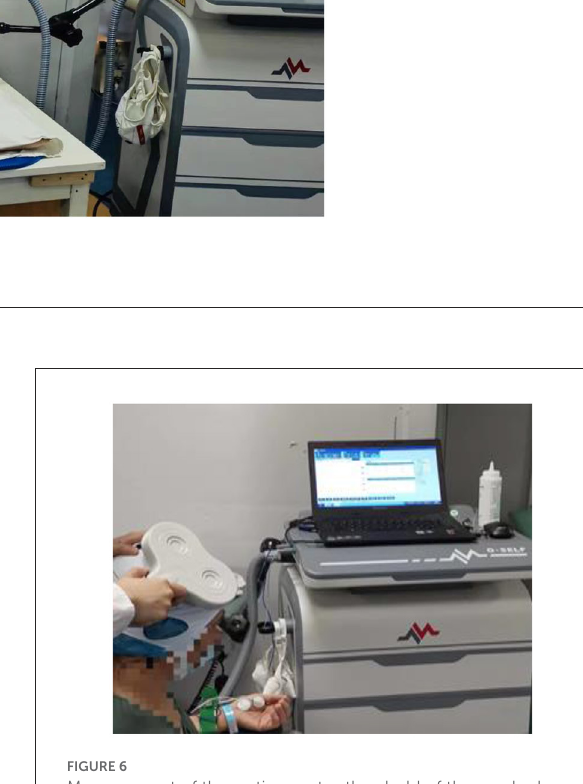
significant ( P < 0.05). When comparing between groups, there was no significant difference in FMA-UE scores between the three groups before or after treatment ( P > 0.05). The difference in the FMA-UE scores (improvement: change from baseline to post-intervention score) was significantly different among the three groups before and after treatment ( P < 0.05) (Table